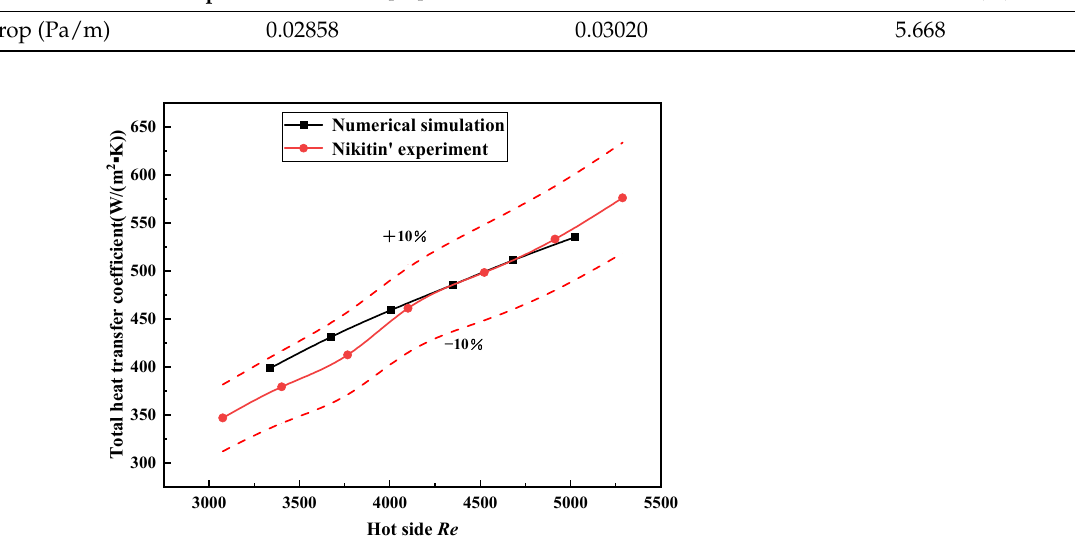
Figure 7. Comparison of simulated and experimental values of total heat transfer coefficient with Reynolds number.